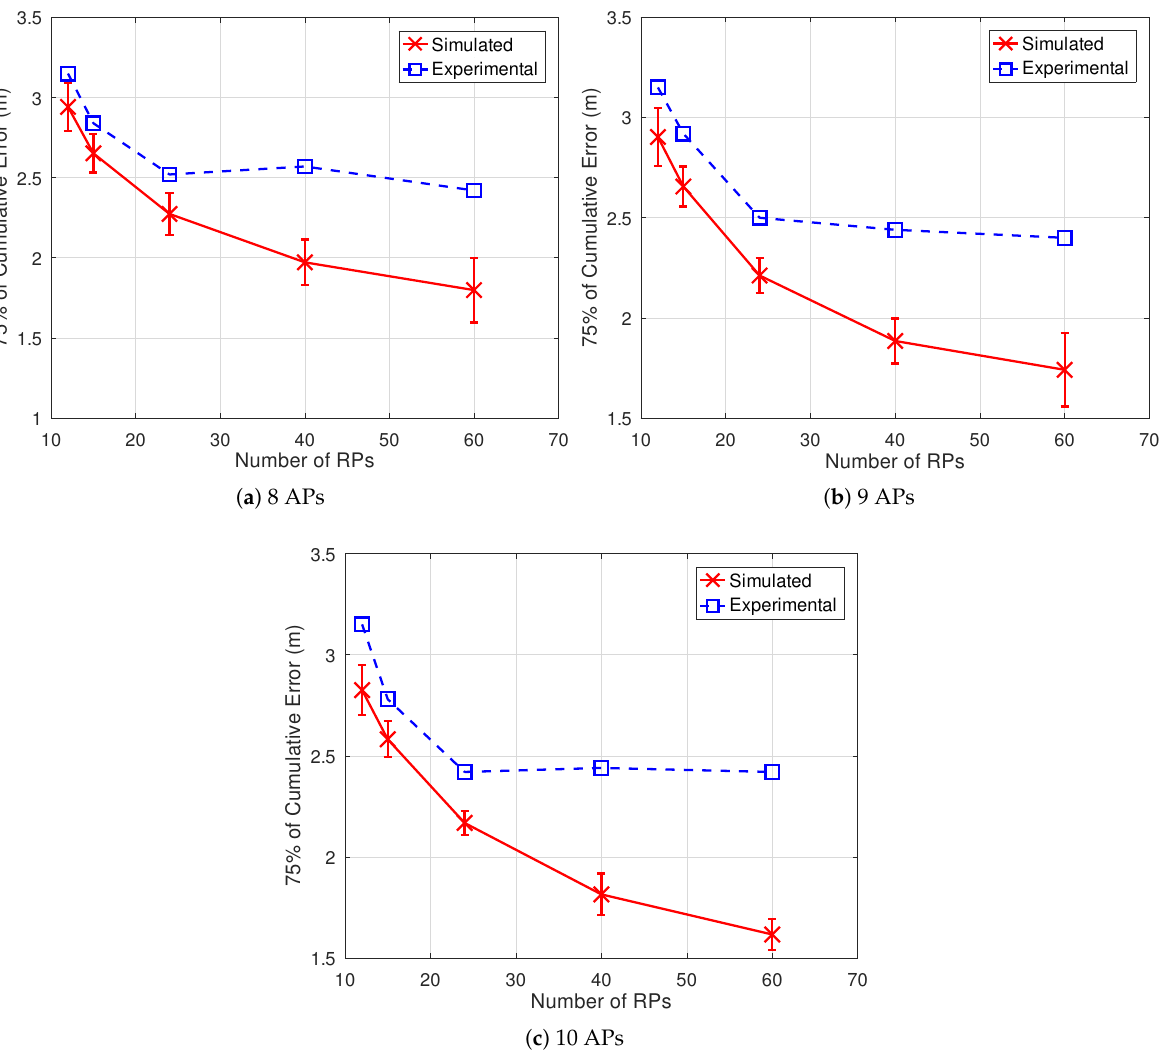
Figure 13. Simulated and experimental errors obtained with 5 samples per